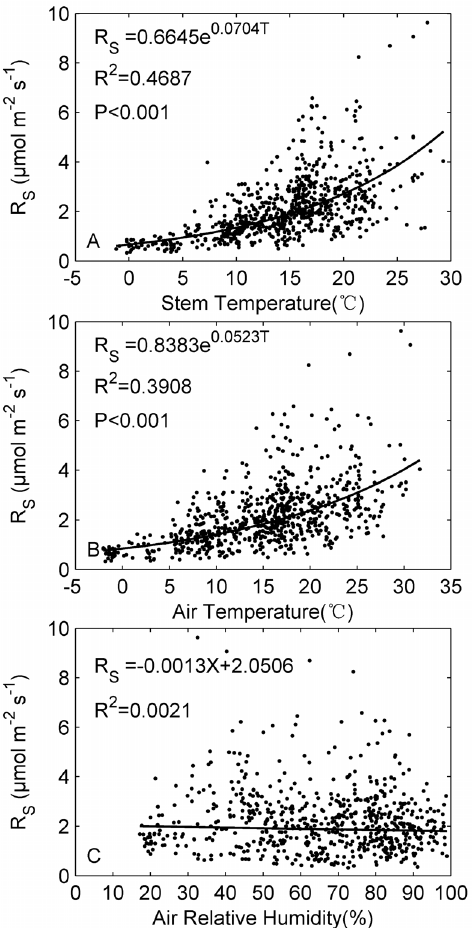
Figure 4. Relationship of the stem respiration per unit surface area (R S ) with (A) stem temperature, (B) air temperature and (C) air relative humidity.